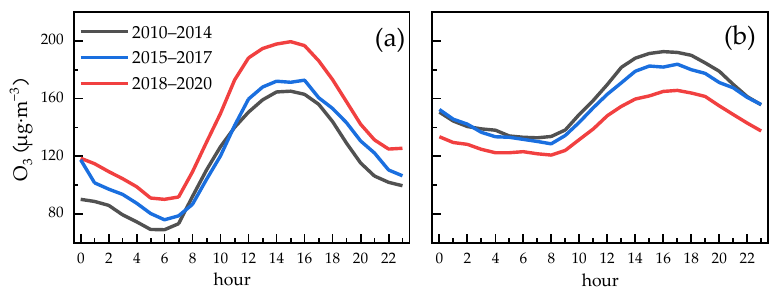
Figure 4. The characteristics of daily ozone variations in June during the period from 2010 to 2020.